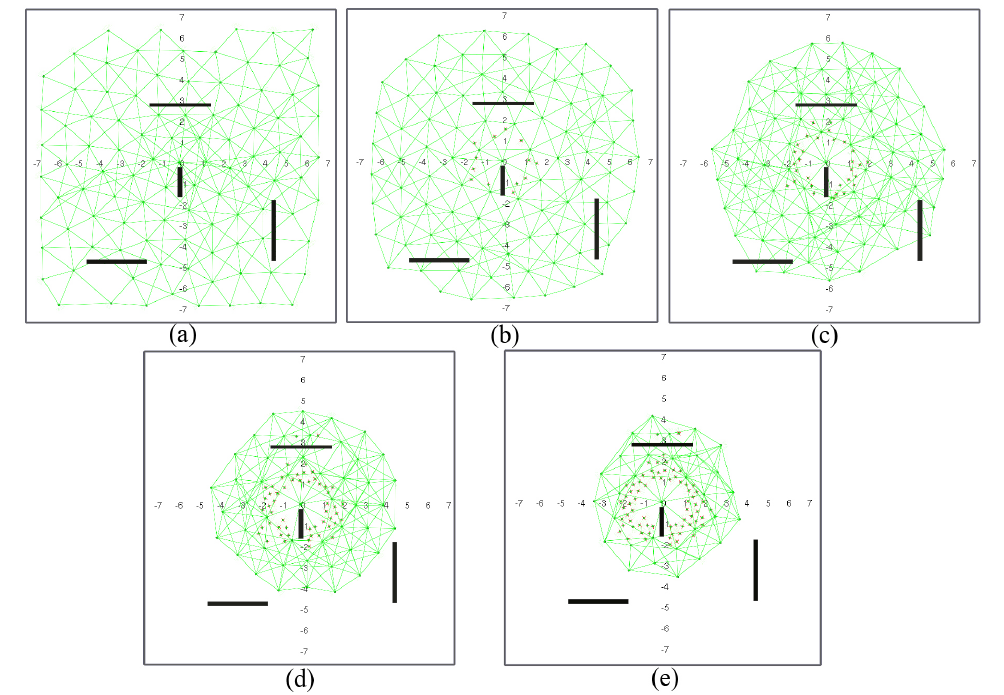
Figure 8. Network configuration when: ( a ) 0%; ( b ) 12.5%; ( c ) 25%; ( d ) 50% and ( e ) 70% of the nodes are dead (figures are scaled 1:10 m).